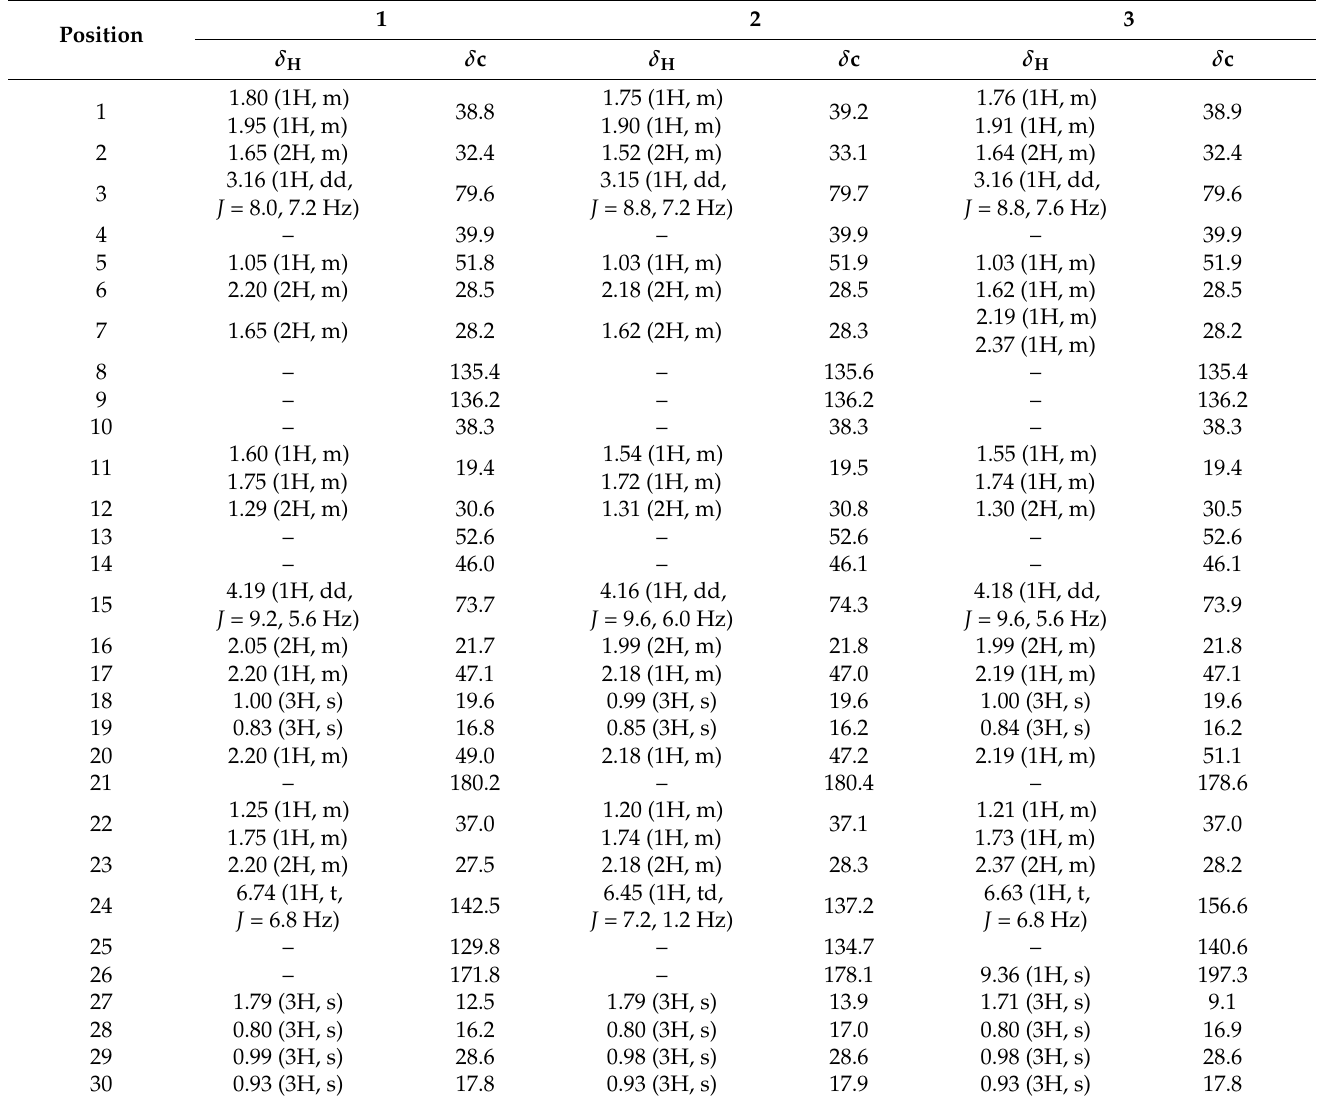
Table 2. 1 H and 13 C NMR spectroscopic data of compounds 1 – 3 .